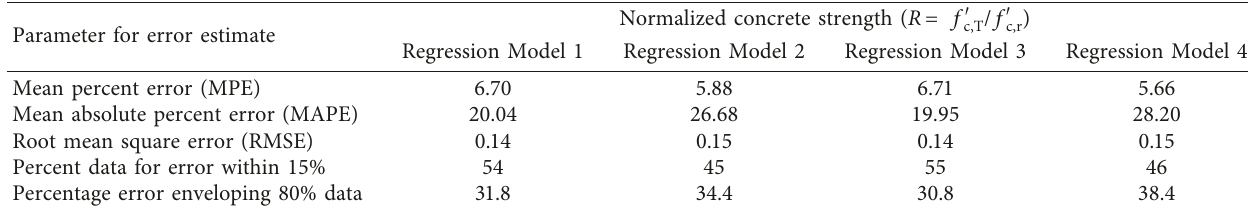
Figure 5: Percentage error in the prediction of normalized strength of HSC for individual data points using (a) regression Model 1, (b) regression Model 2, (c) regression Model 3, and (d) regression Model 4. Table 6: Error estimates for different predictive